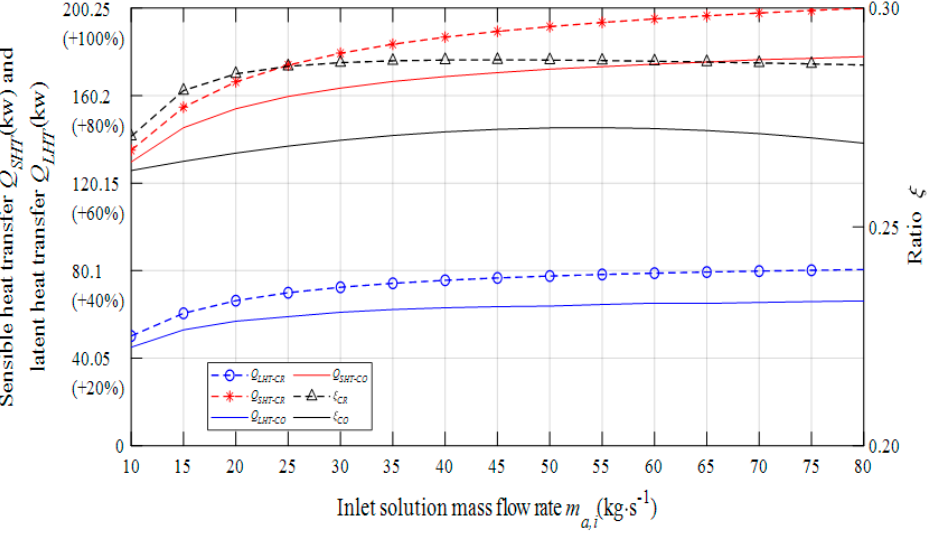
Figure 16. Influence of solution inlet mass flow rate on energy transfer characteristics.